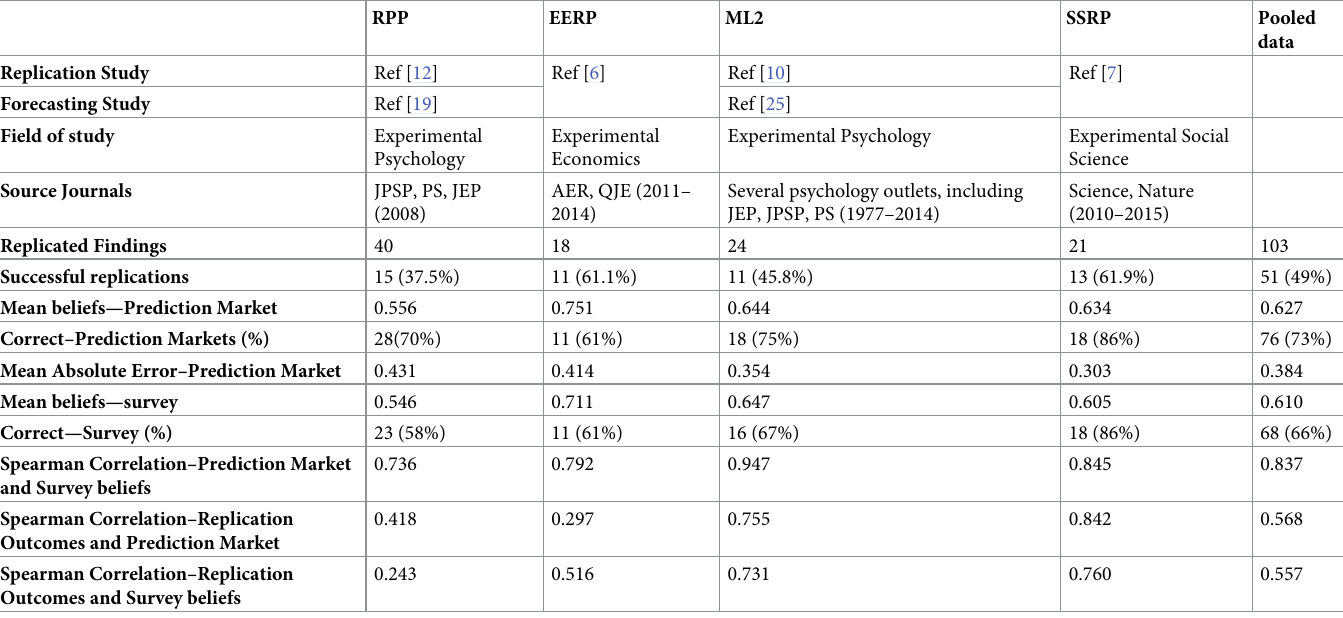
Table 1. Main features of individual